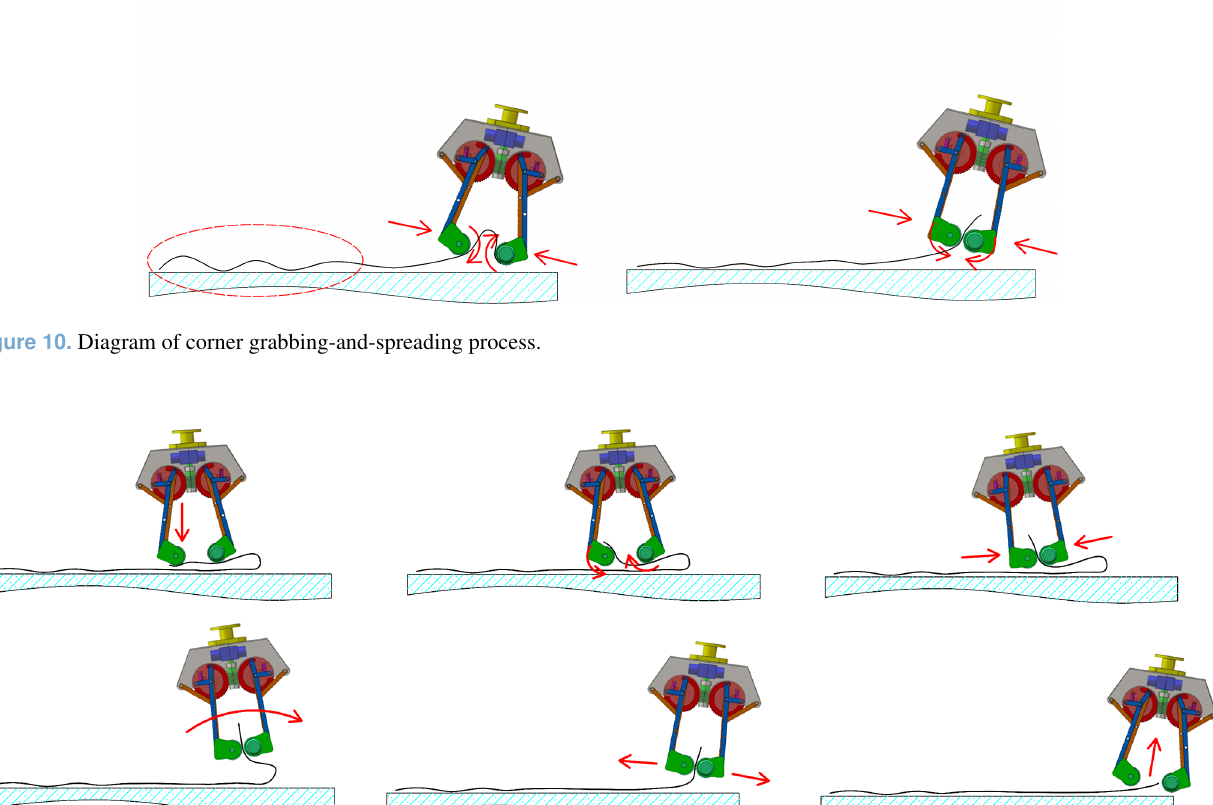
Mech. Sci., 14, 111–123,